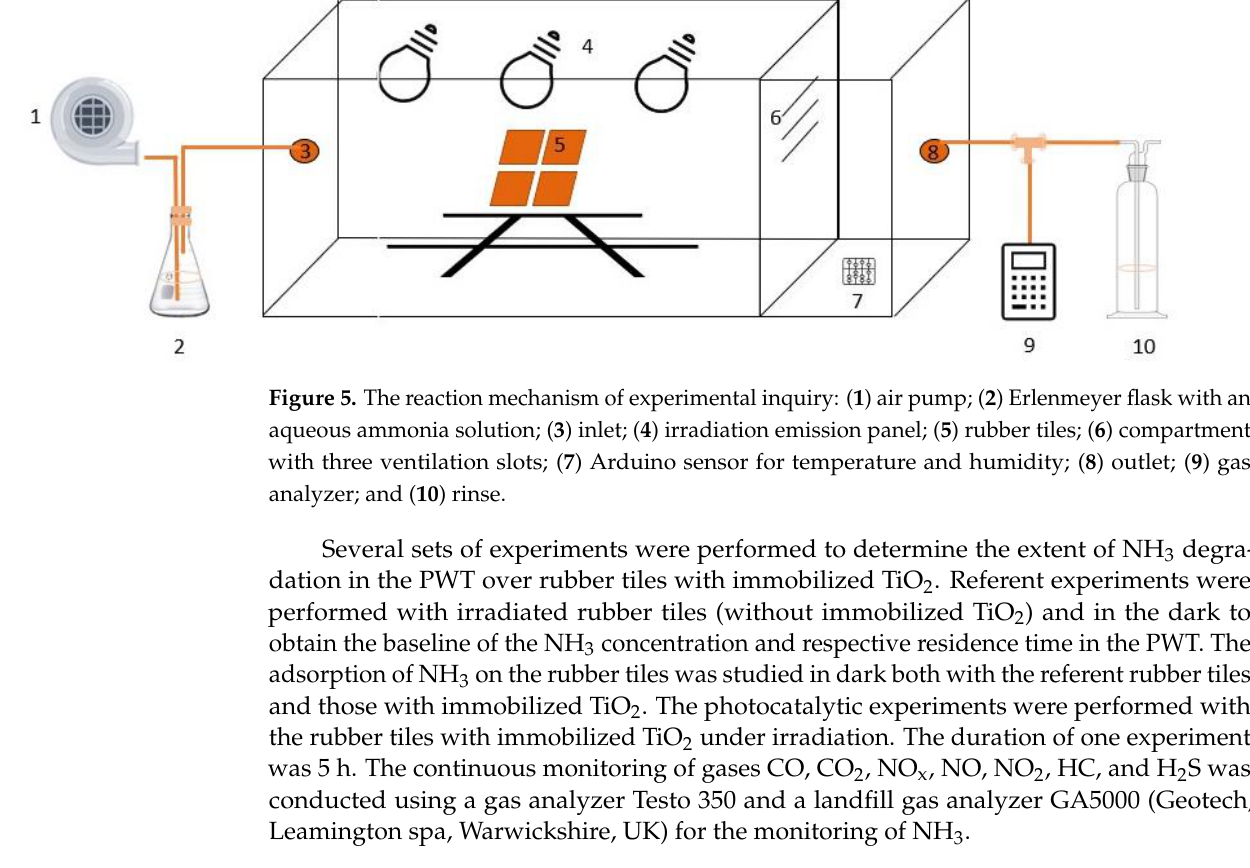
Table 1. Weighing results of samples